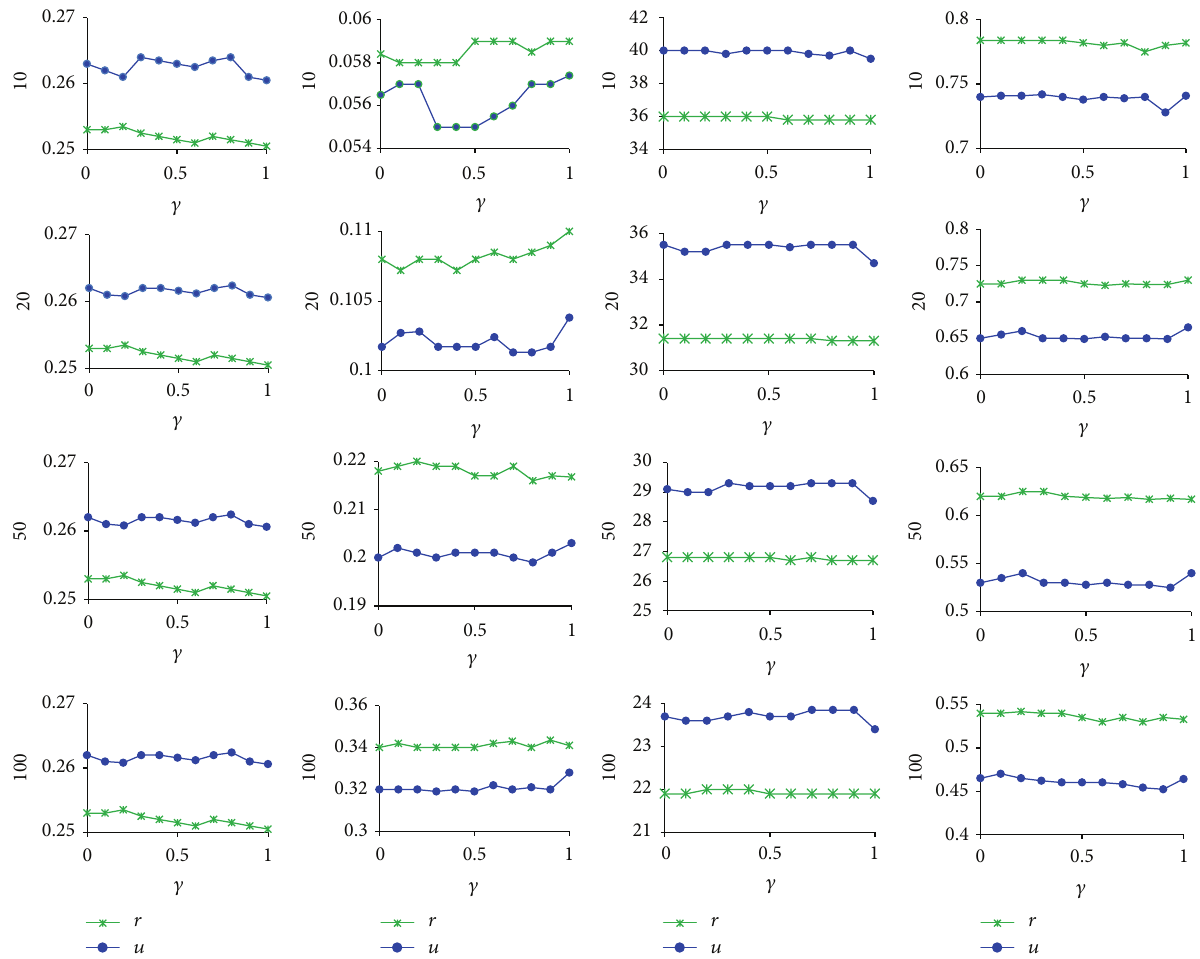
Figure 4: Results of UCBCR. It successively reports the rank accuracy, hitting rate, popularity, and diversity base on different length of recommend lists and different community structures under each parameter values. Illustrations 𝑢 and 𝑟 express the results base on user communities in Figures 2 and 3,